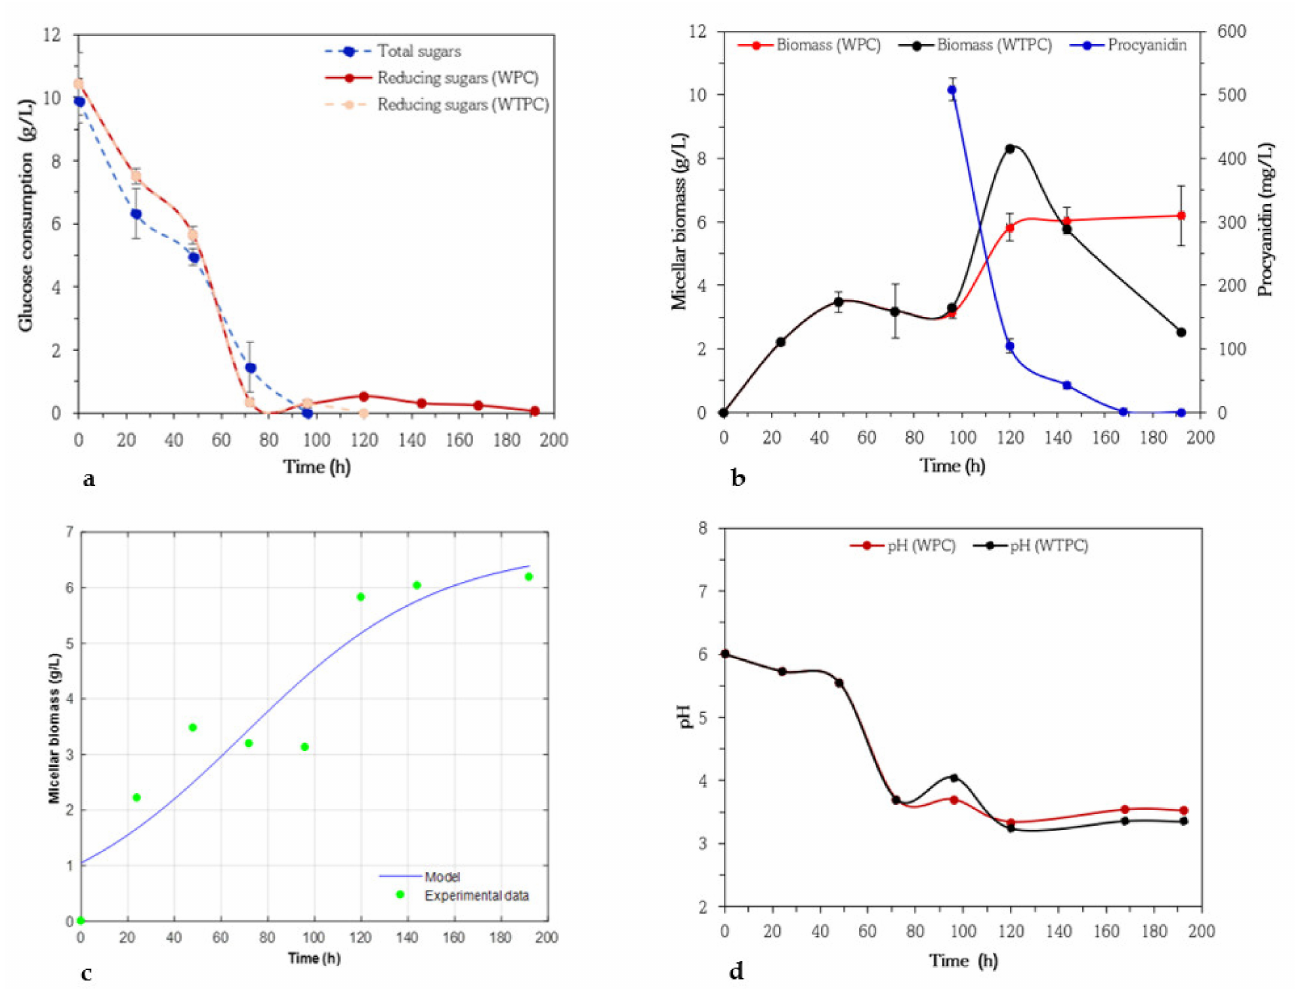
Figure 2. Variation of glucose concentrations by anthrone and 3,5 dinitrosalicylic acid (DNS) methods ( a ), micellar biomass in culture medium with (WPC) and without addition of procyanidins (WTPC) when glucose was below 3.0 g/L (stationary phase), and changes in procyanidin concentrations ( b ) in submerged cultures of Aspergillus niger GH1. Micellar biomass production by Aspergillus niger GH1 in submerged cultures using basic medium of salts and glucose (10 g/L) and with addition of procyanidin when glucose was below 3.0 g/L (stationary phase). Symbols represent experimental data. Solid lines represent calculated data ( c ), Evolution of pH in submerged cultures of Aspergillus niger GH1 in medium with (WPC) and without (WTPC) addition of procyanidins when glucose was below 3.0 g/L (stationary phase) ( d